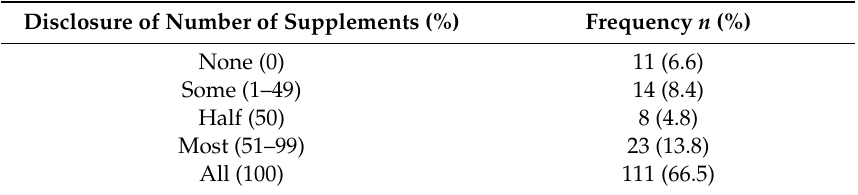
Table 5. Disclosure of supplement use to